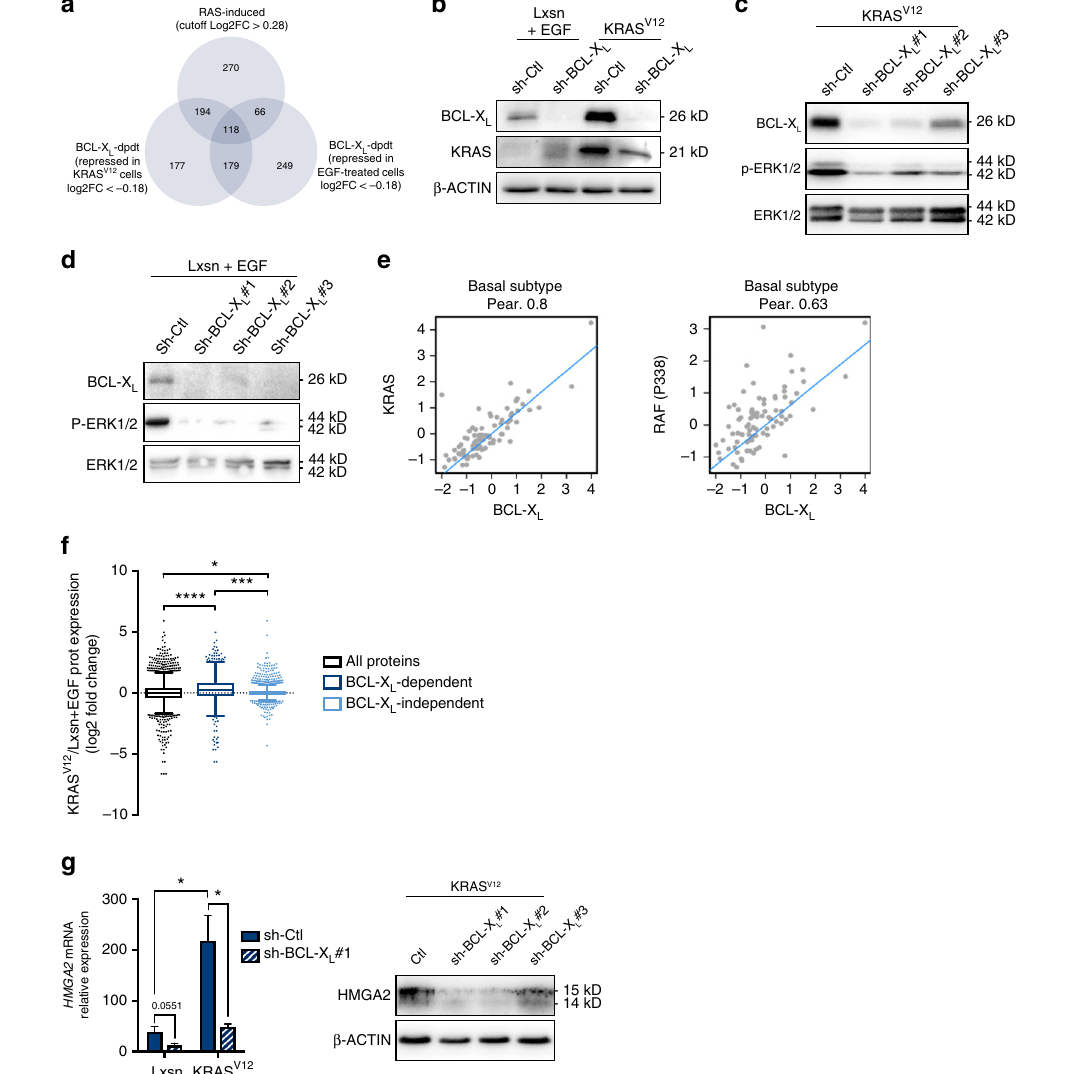
impact on KRAS mRNA expression (Supplementary Fig. 5b), whereas it enhanced the ability of cycloheximide (a protein synthesis inhibitor) to decrease KRAS protein levels (Supple- mentary Fig. 5c). RAS proteins have been reported to be subject to proteasomal 18 and/or lysosomal 19 degradation. BCL-X L appears to protect RAS from the latter and not from the former,